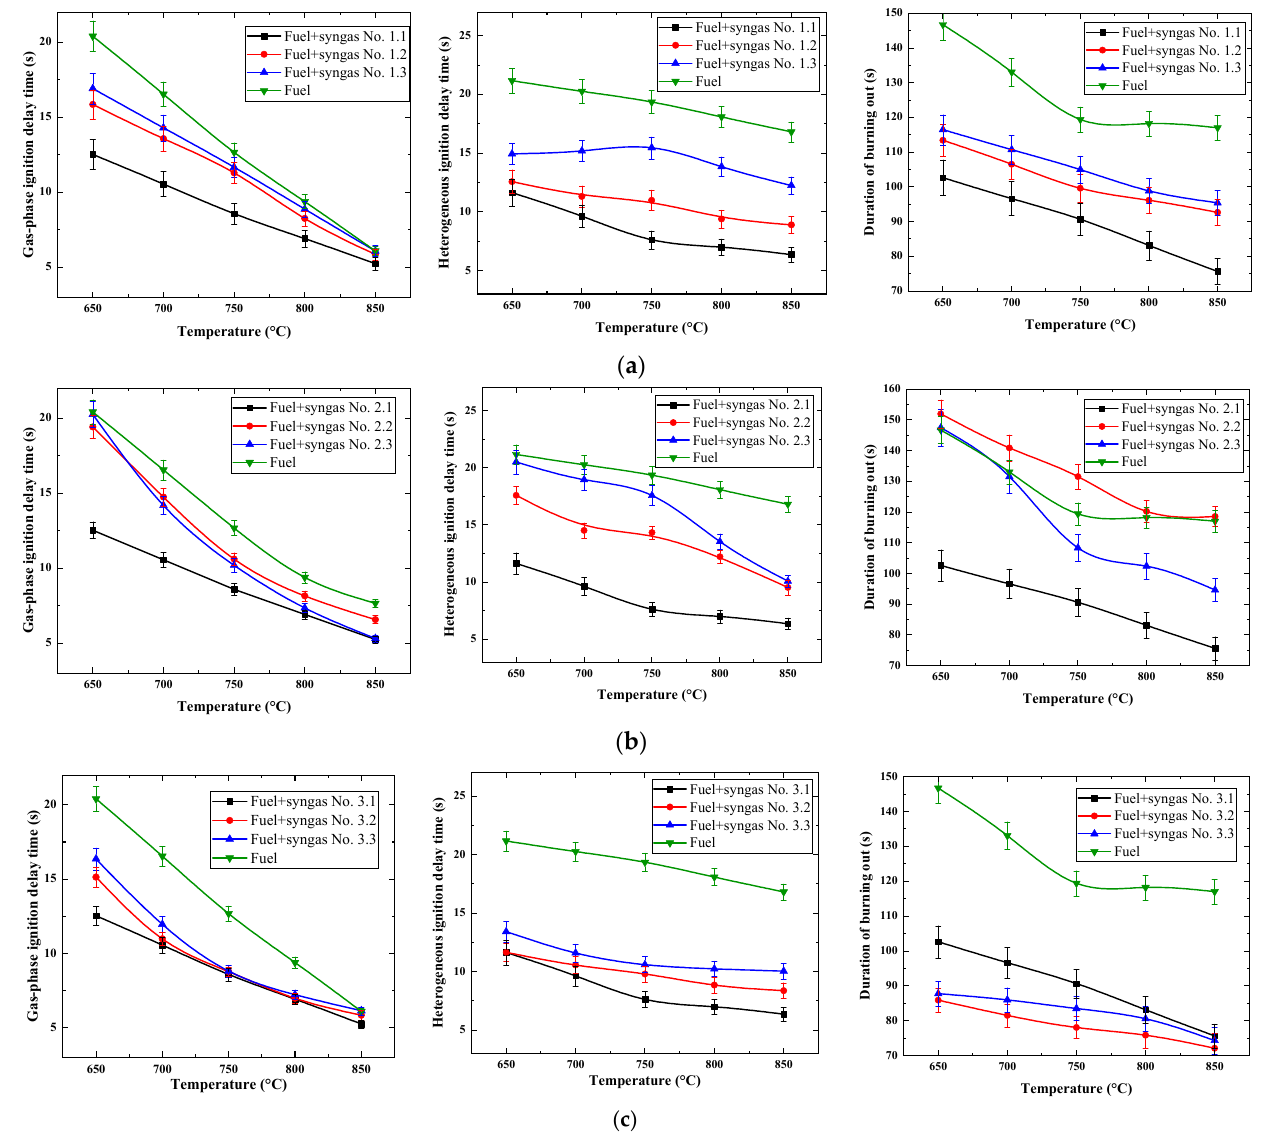
Figure 4. Dependences of the CWS droplet ignition delay times on the temperature of the combustion chamber with synthesis gases obtained under different conditions: ( a ) initial weights of the pyrolyzed fuels are identical; ( b ) calorific values of the pyrolyzed fuels are identical; ( c ) volatiles content in the samples of pyrolyzed fuels is identical.